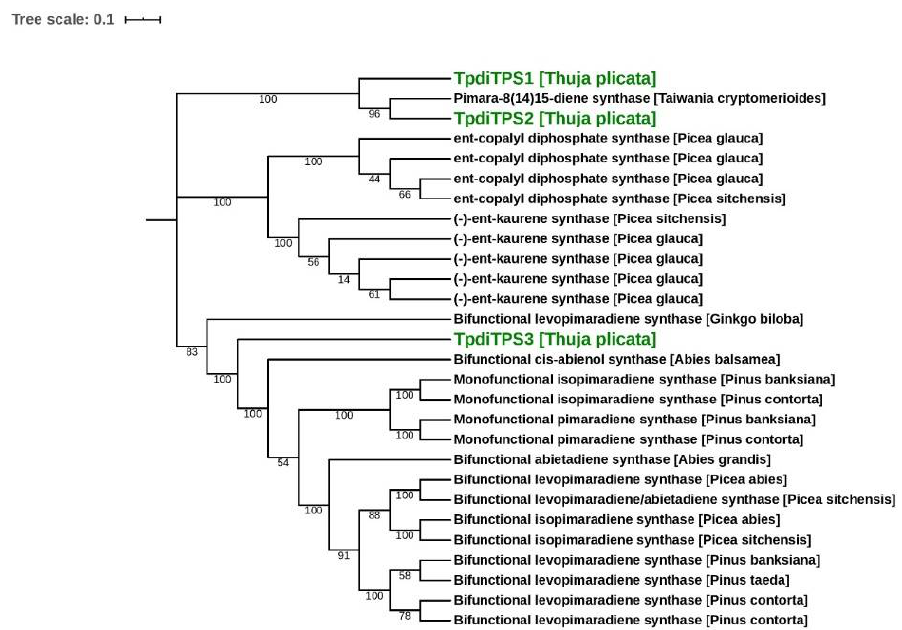
Figure 1. Phylogenetic tree of conifer diterpene synthases. Phylogenetic analysis was performed with 28 full-length diterpene synthases. Proteins identified in this study are highlighted in green. TPS (Terpene Synthases) of the Cupressaceae, except for the TPdiTPS3 cluster apart from TPS of the Pinaceae, indicative of the independent diversification and evolution of specific TPS functions in the Cupressaceae and the Pinaceae. Scale bar indicates 0.1 amino acid substitution per site. The number shows bootstrap confidence values from 100 replicates.